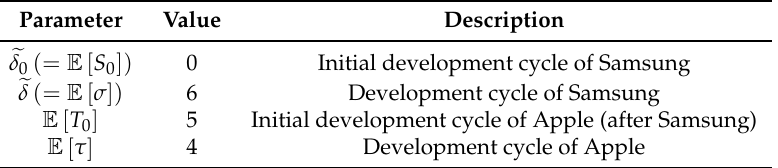
Table 2. Initial setup values for the case